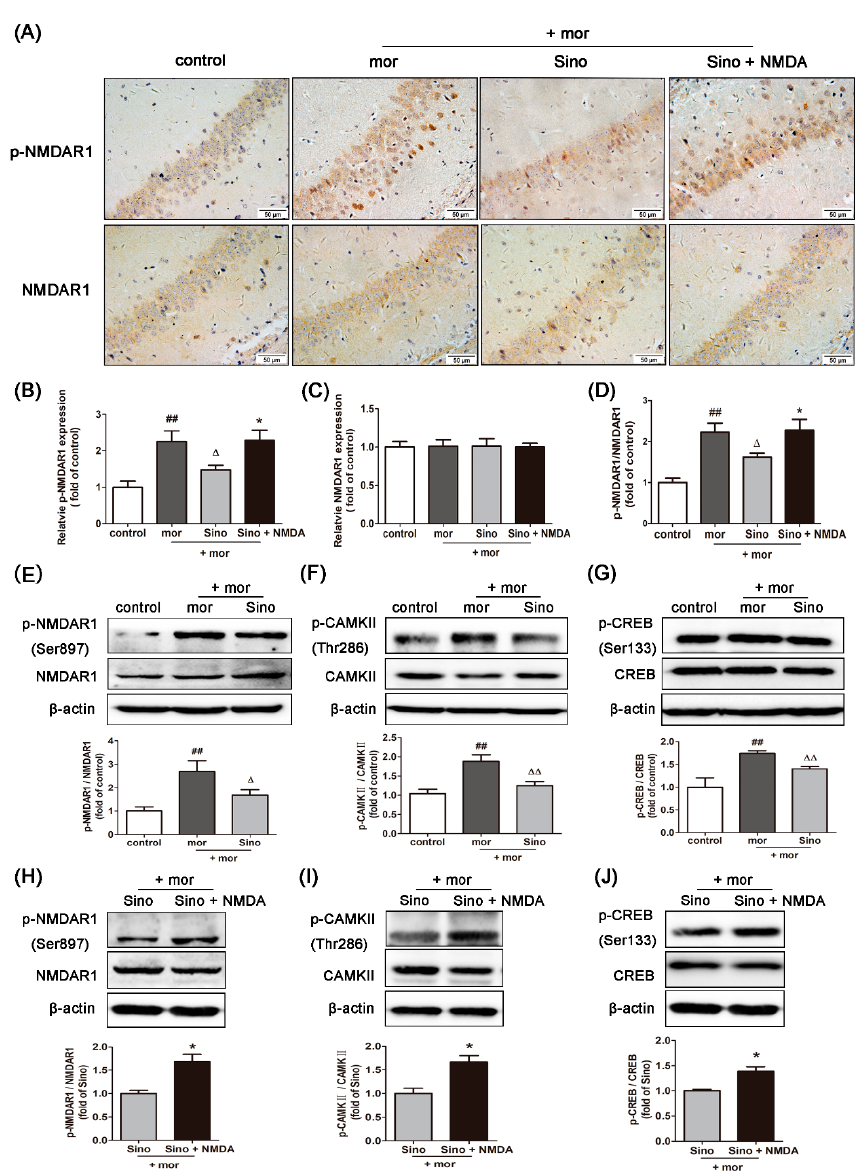
Figure 2. Sinomenine inhibited the expressions of p-NMDAR1/NMDAR1, p-CAMKII/CAMKII, and p-CREB/CREB in the hippocampus of morphine-dependent mice. ( A – D ) Immunohistochemistry analysis was used to quantify the expression levels of p-NMDAR1 and NMDAR1 in the hippocampus of morphine-dependent mice ( n = 3); ( E – J ) Western blotting analysis was used to quantify the expression levels of p-NMDAR1/NMDAR1, p-CAMKII/CAMKII, and p-CREB/CREB in the hippocampus ( n = 3). ## p < 0.01 vs. control; Δ p < 0.05, ΔΔ p < 0.01 vs. mor; * p < 0.05 vs. Sino.